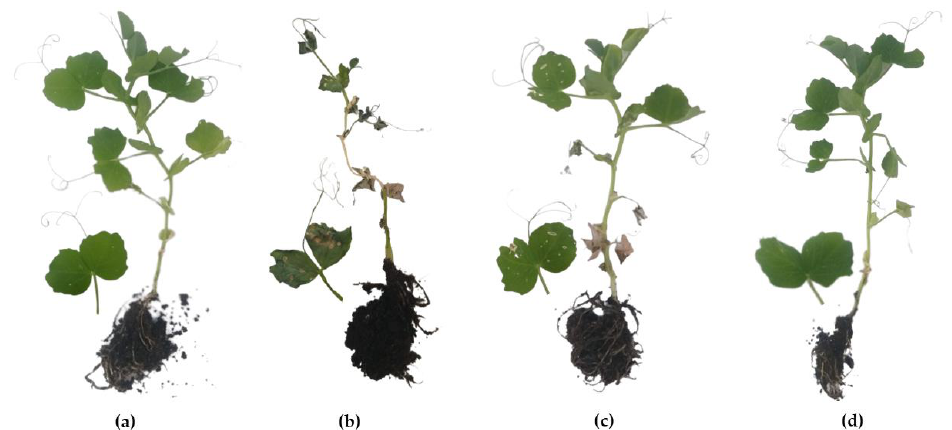
Figure 5. Symptoms of bacterial blight produced by P. syringae pv. pisi in plants of pea cv. “Lincoln” after 10 days of inoculation: ( a ) negative control; ( b ) positive control; ( c ) G. biloba leaf extract at 750 μg∙mL −1 ; and ( d ) G. biloba leaf extract at 1500 μg∙mL −1 .